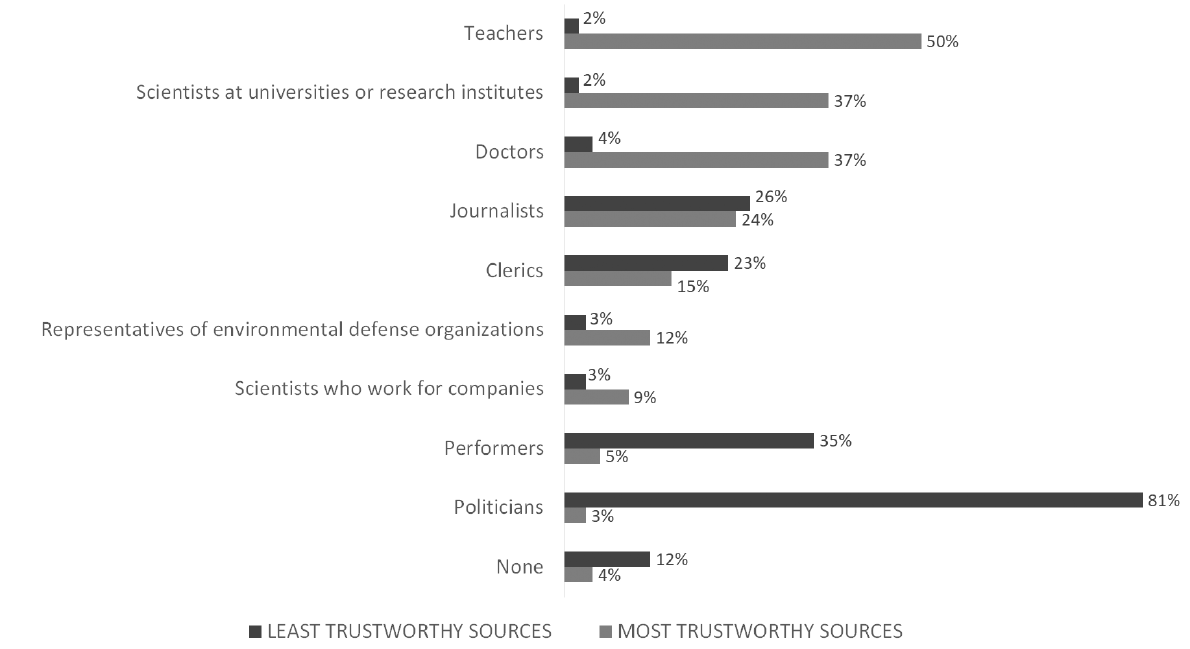
Figure 1. Sources of information deemed most and least trustworthy (respondents could choose two). Survey questions related to Figure